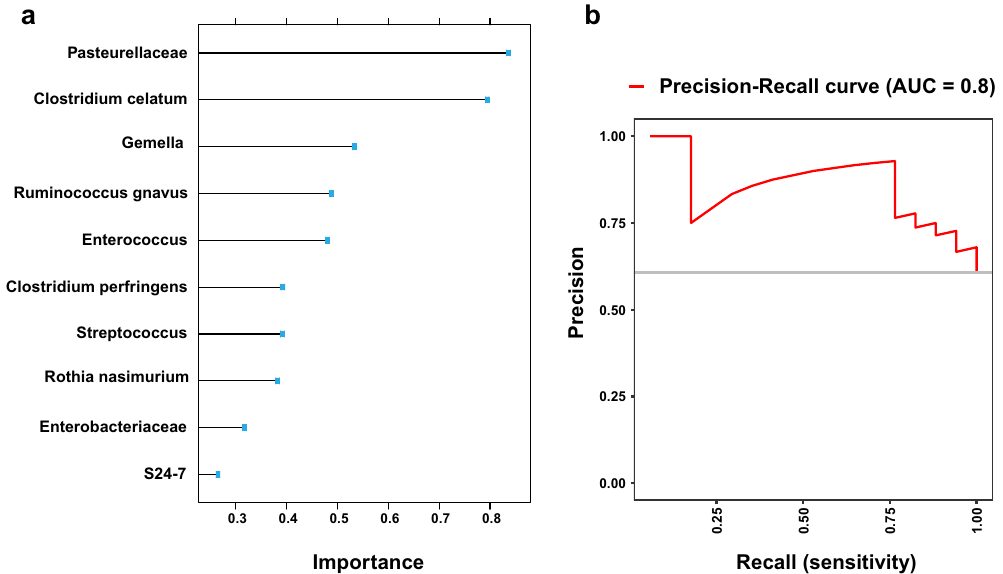
Fig. 7 Prediction model of the outcome of neonatal puppies based on the rectal microbiome of healthy puppies and puppies that later succumbed to FPS on Day 1 post-partum. a Top 10 most predictive (important) bacterial taxa for the model performance; b Precision-Recall curve, showing the actual model predictive performance (AUC =